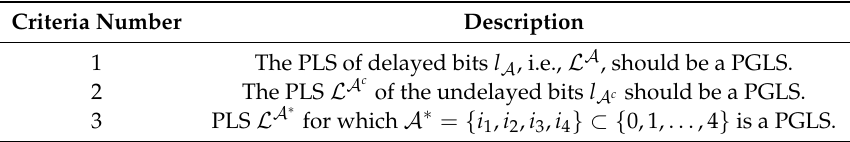
Table 1. The proposed criteria for good